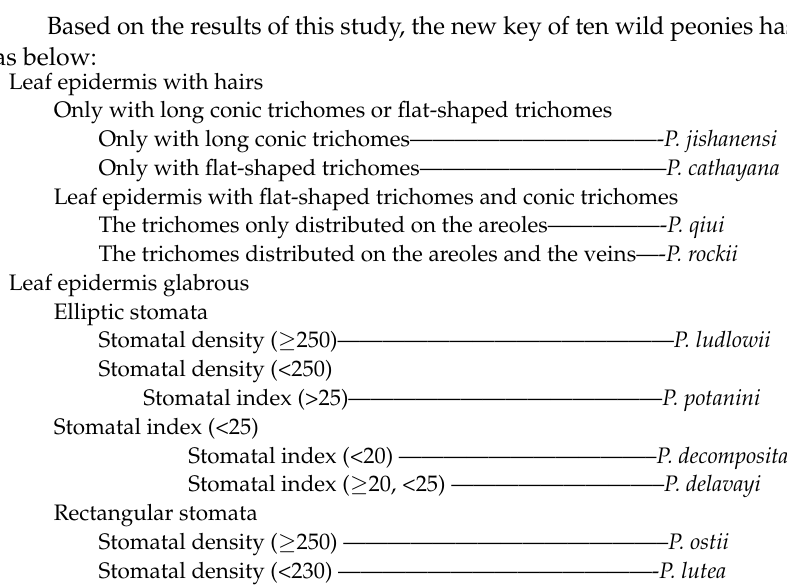
Figure 8. Trichomes under scanning electron microscopy. ( A , B ) P. qiui ; ( C , D ) P. rockii ; ( E , F ) P. jishanensis ; ( G , H ) P. cathayana . Abbreviations: ft: flat-shaped trichomes; lt: long conic trichomes; ct: conic trichomes. (bar = 100 μ m).